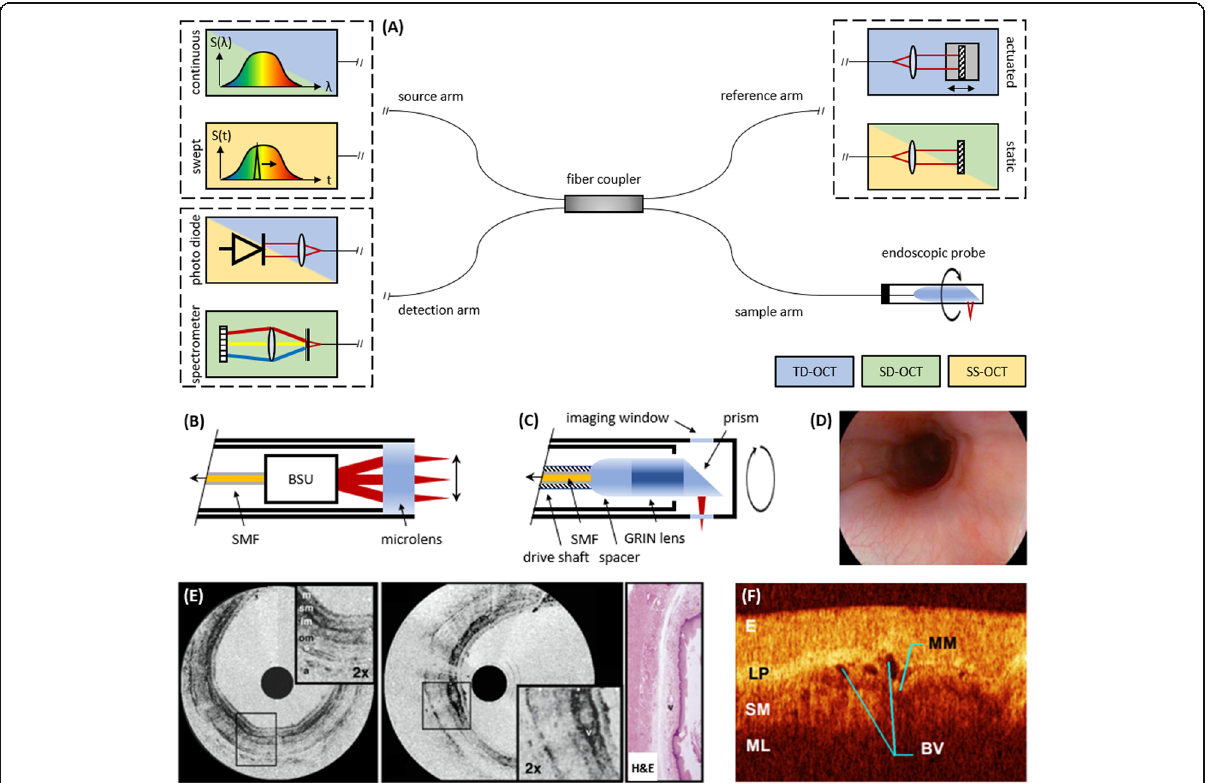
Fig. 3 Milestone 1: Principles of endoscopic OCT. a Fiber-based Michelson interferometer endoscopic OCT setup sketch illustrating the different OCT configurations. Time-domain (TD) OCT (blue) vs. Fourier-domain (FD: spectral-domain (SD) OCT (green) vs. swept source (SS) OCT (yellow)) OCT. b and c illustrate the two fundamental types of endoscopic OCT imaging probes – forward-viewing ( b ), including a non-specified beam scanning unit (BSU), and side-viewing ( c ). d Exemplary WLE image of a human esophagus in vivo . e and f depict reprints from a first preclinical in vivo and a first-in-human report, respectively. e shows first circular OCT scans of a rabbit ’ s esophagus in vivo (figure and caption adapted and reprinted with permission from [44] © The American Association for the Advancement of Science ). f shows a linear OCT scan of esophageal tissue